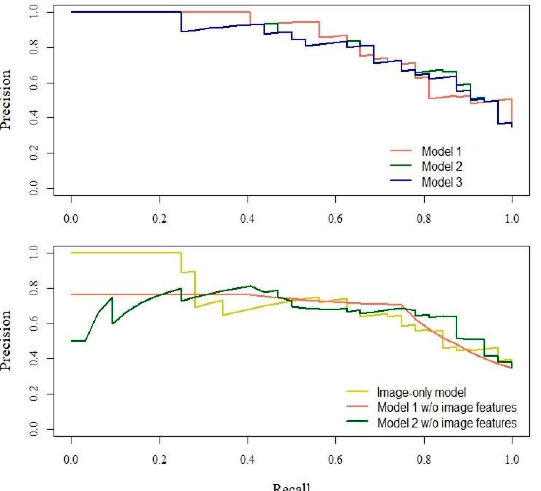
Figure 5. Precision-recall curves for the screening models. Model 1: sex, categorized BMI, median pixel value, IQR of pixel value, number of feature points. Model 2: age, sex, categorized BMI, median pixel value, IQR of pixel value, number of feature points. Model 3: age, sex, categorized BMI, IQR of pixel value, number of feature points. Image-only model: median pixel value, IQR of pixel value, number of feature points. Abbreviations: BMI, body mass index; IQR, interquartile range; w/o = without.